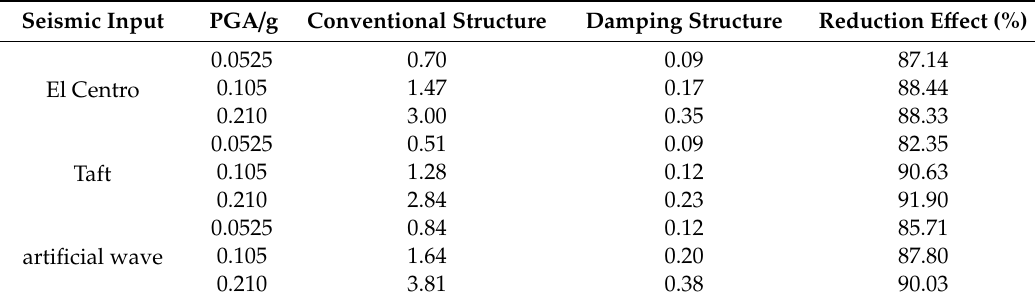
Table 6. Acceleration of first suspended floor.